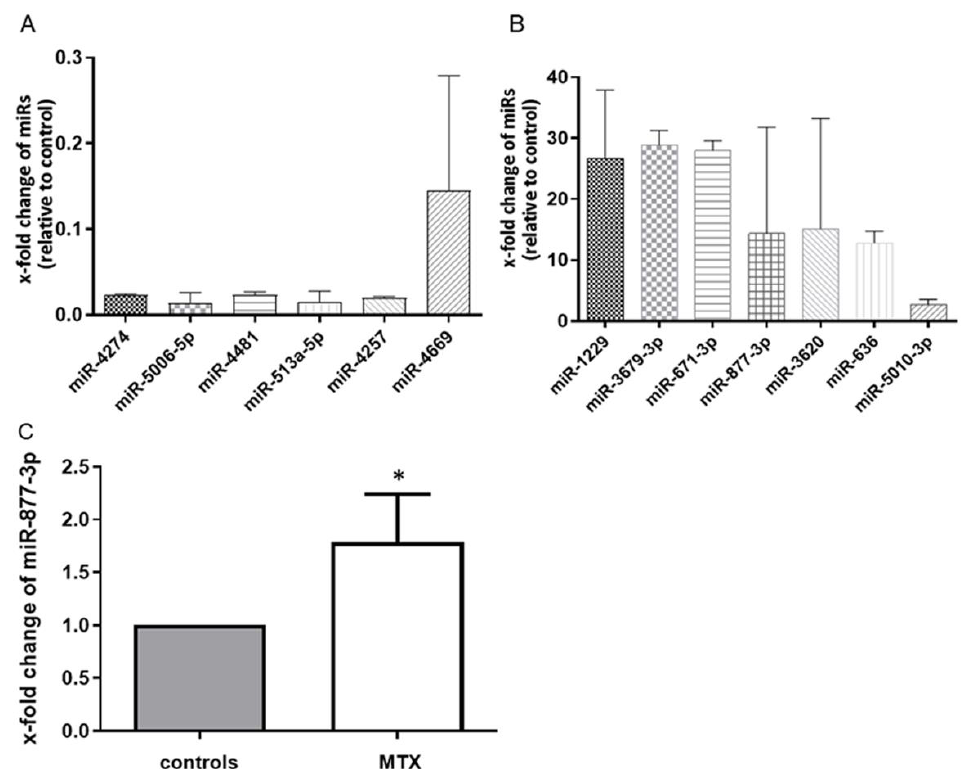
Figure 1. MTX altered the global expression profile of RA-FLS ( n = 3). ( A ) the six microRNAs in the downregulated group. ( B ) the seven microRNAs in the upregulated group. Values are the means of three pairs (RA-FLS treated with MTX vs. untreated RA-FLS). We defined “ altered miRNA ” that were upregulated or downregulated in all three pairs. ( C ) the expression of microRNA-877-3p (miR- 877-3p) in RA-FLS treated with MTX as determined by TaqMan-based RT-PCR. The expression of miR-877-3p in RA-FLS treated with MTX was determined relative to untreated RA-FLS, which was set as 1. MiR-877-3p was upregulated in RA-FLS after 48 h MTX treatment ( n = 7). Values are pre- sented as means ± SD. * p < 0.05 versus control.